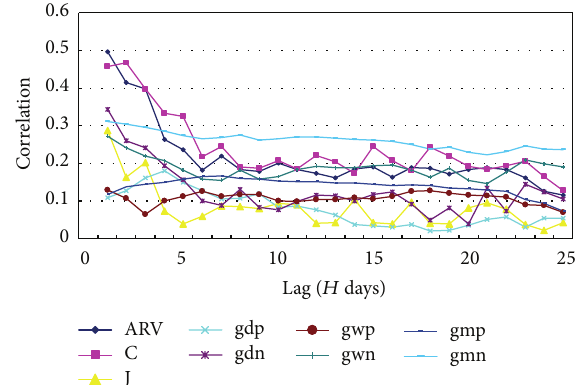
Figure 1: Lagged correlation function between ARV 𝑡+ℎ and 𝑋 𝑡